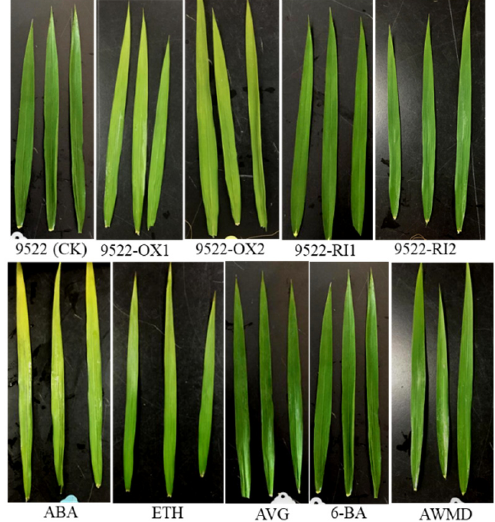
Figure 2. Changes in leaf color of wildtype and transgenic lines, following application of application of exogenous phytohormone/alternate wetting and under moderate drying (AWMD) irrigation at 15 days post anthesis. Symbols are as described in Figure 1.